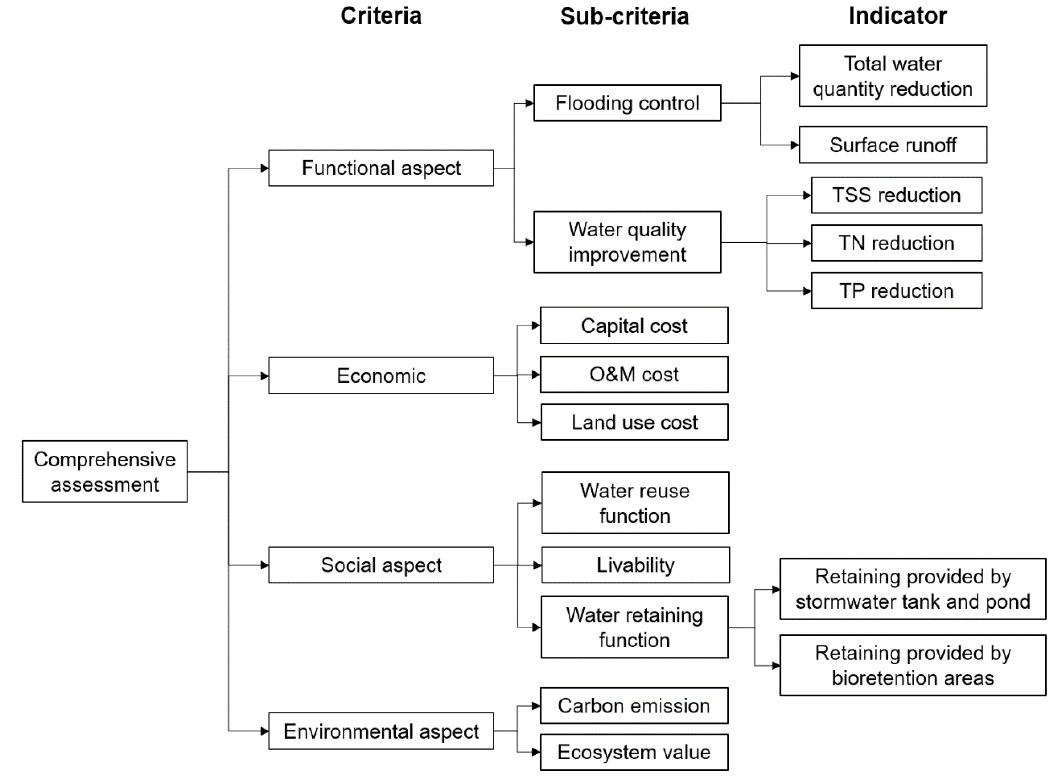
Figure 5. The selected criteria, sub-criteria, and indicators for comprehensive assessment.